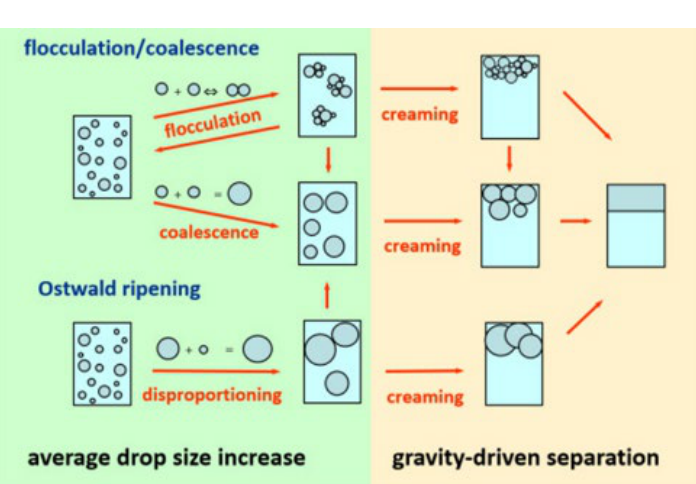
Figure 7. Thermodynamic demulsification phenomenon in nano-emulsions [156]. Reproduced